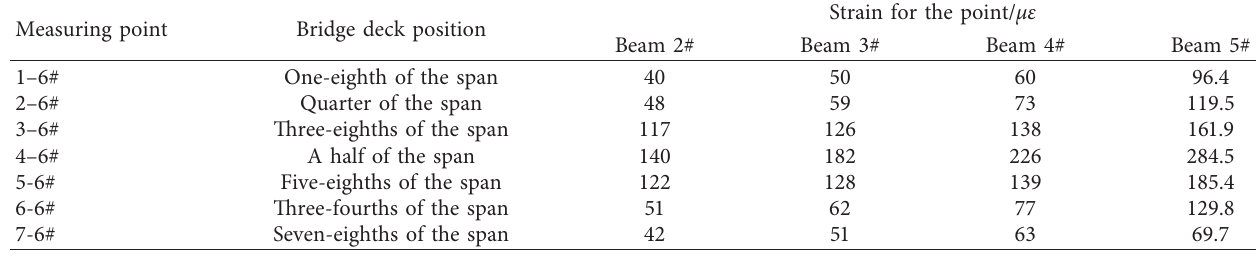
Table 8: Tensile strain measurements under normal loading (32.2 t ).